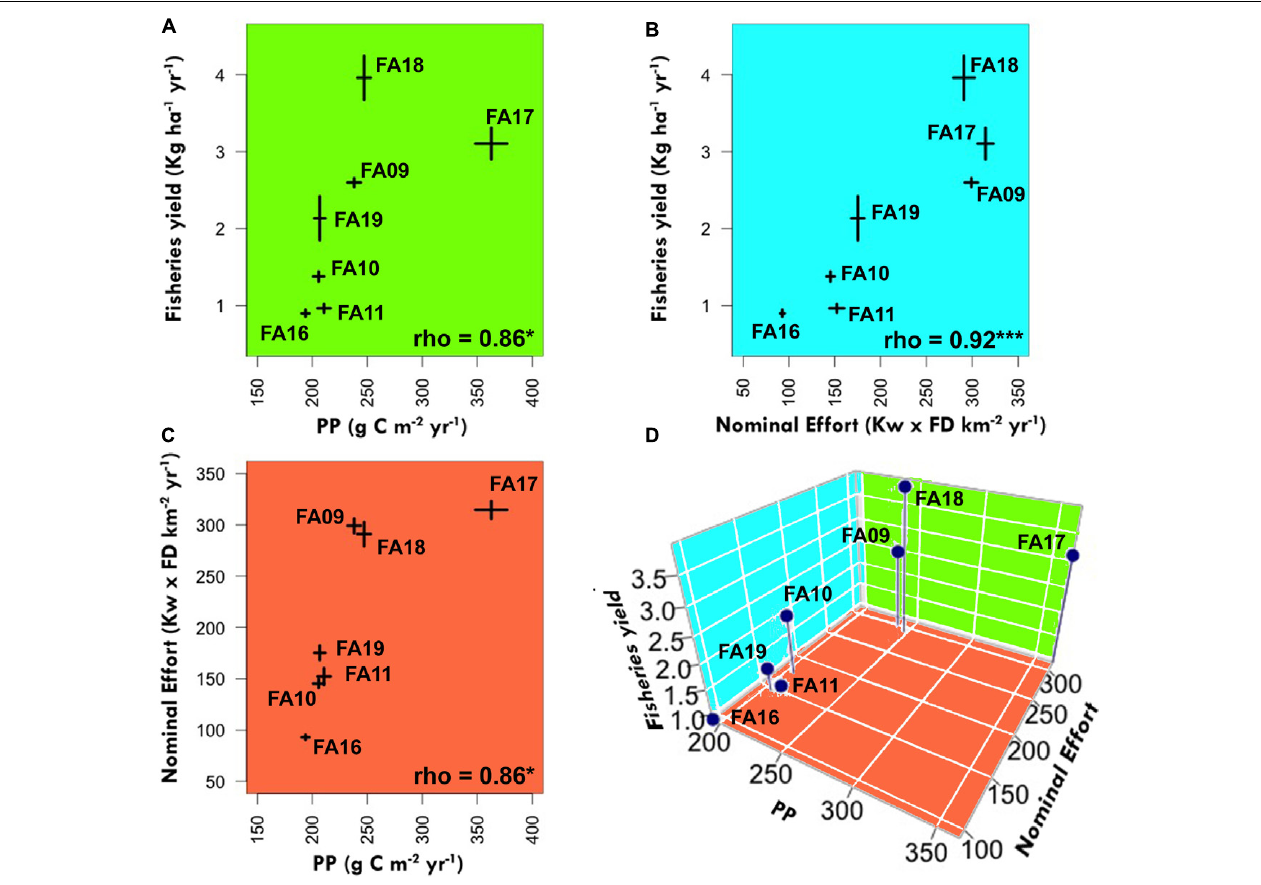
FIGURE 7 | Relationships between: (A) primary productivity (PP) and fisheries yield for demersal species; (B) nominal effort and fisheries yield; (C) primary productivity (PP) and nominal effort; (D) all the three factors together. Variability in PP (horizontal bars) and fisheries yield (vertical bars) are shown, for each FA in the parts (A–C) of the plot, as standard error around the mean